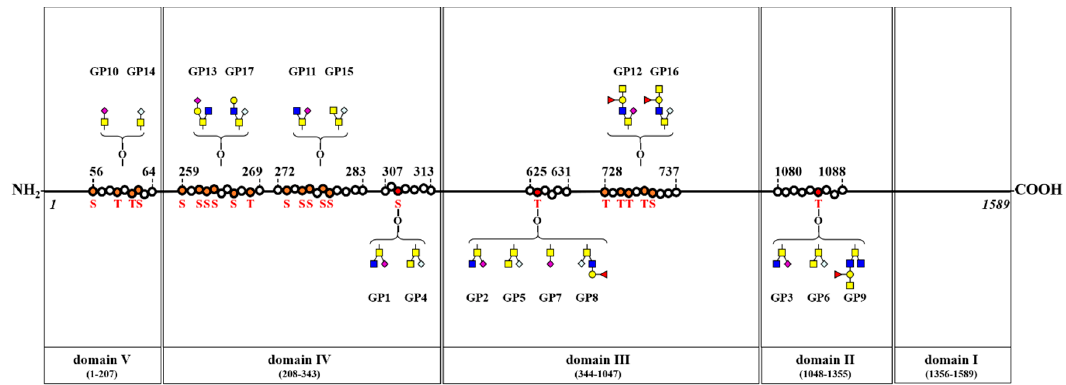
Figure 4. Schematic representation of O -glycosylation sites on four domains of BSM. Three O -glycosylation sites in each glycopeptide ( 307 RPSYGAL, 625 QTLGPL, and 1080 RPEDNTAVA) and four O -glycosylation sites in each glycopeptide ( 56 SGETRTSVI, 259 SHSSSGRSRTI, 272 GSPSSVSSAEQI, and 728 TMTTRTSVVV). A red S or T indicates an O -glycosylation site of BSM.